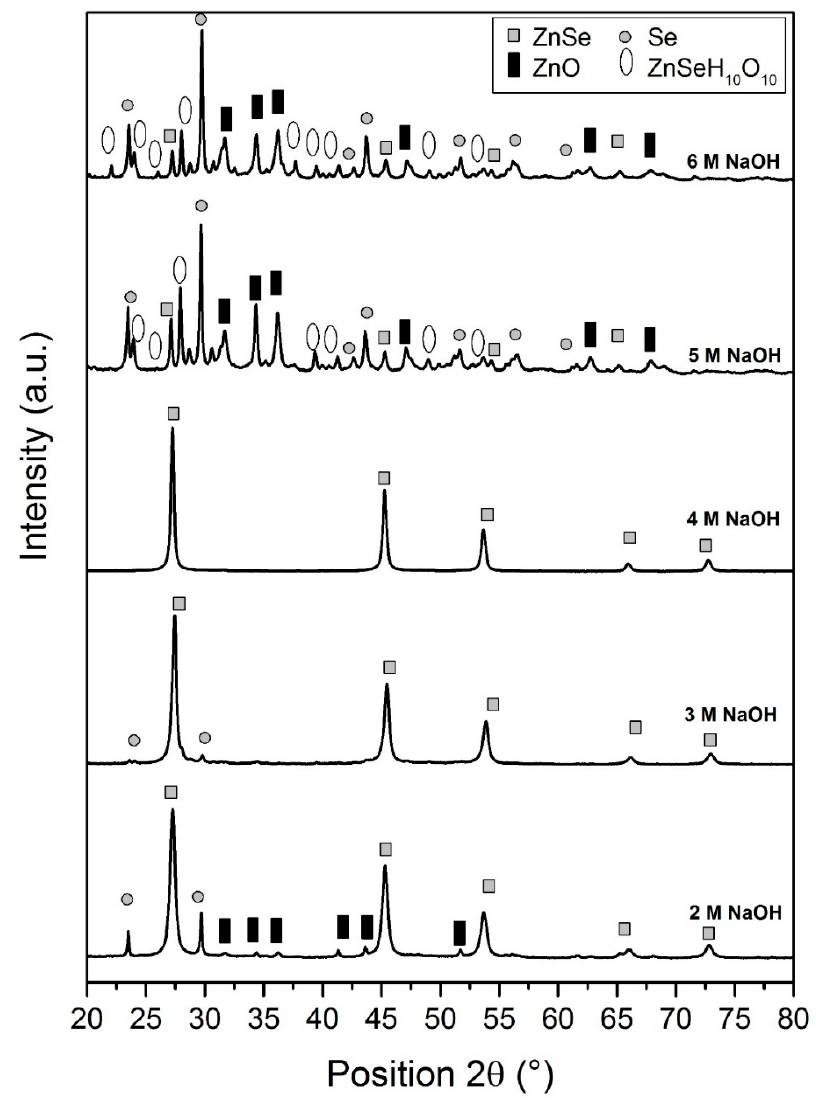
Figure 1. XRD spectra of the zinc selenide / graphene oxide (ZnSe / GO) composite by varying the sodium hydroxide (NaOH) concentration. Table 1 . Phases of the synthesized ZnSe/GO composite by varying the NaOH concentration.